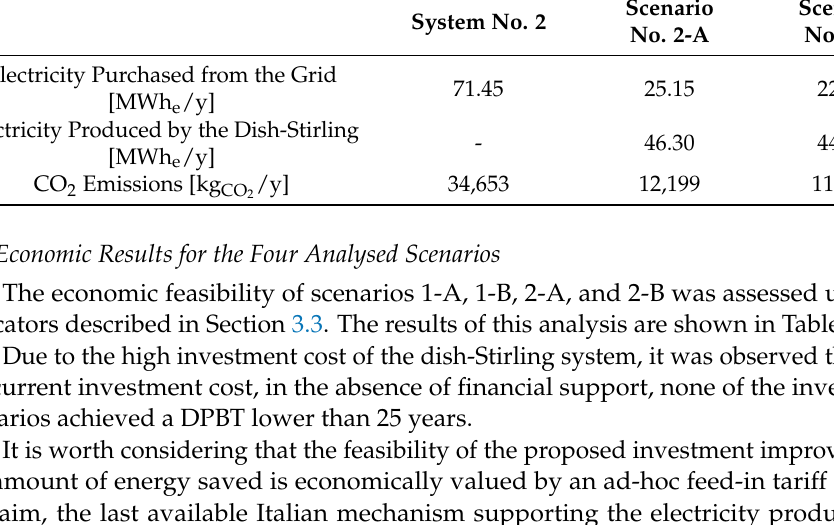
Table 4. Annual results for System no. 2, Scenario no. 2-A, and Scenario no. 2-B. System No.